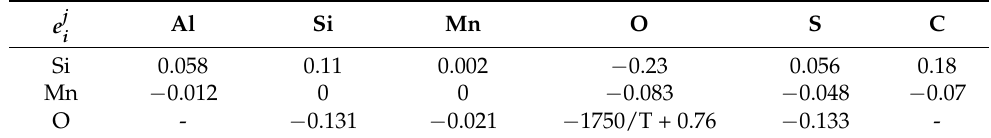
Table 5. Interaction coefficients used in thermodynamic calculation [16,20,21].